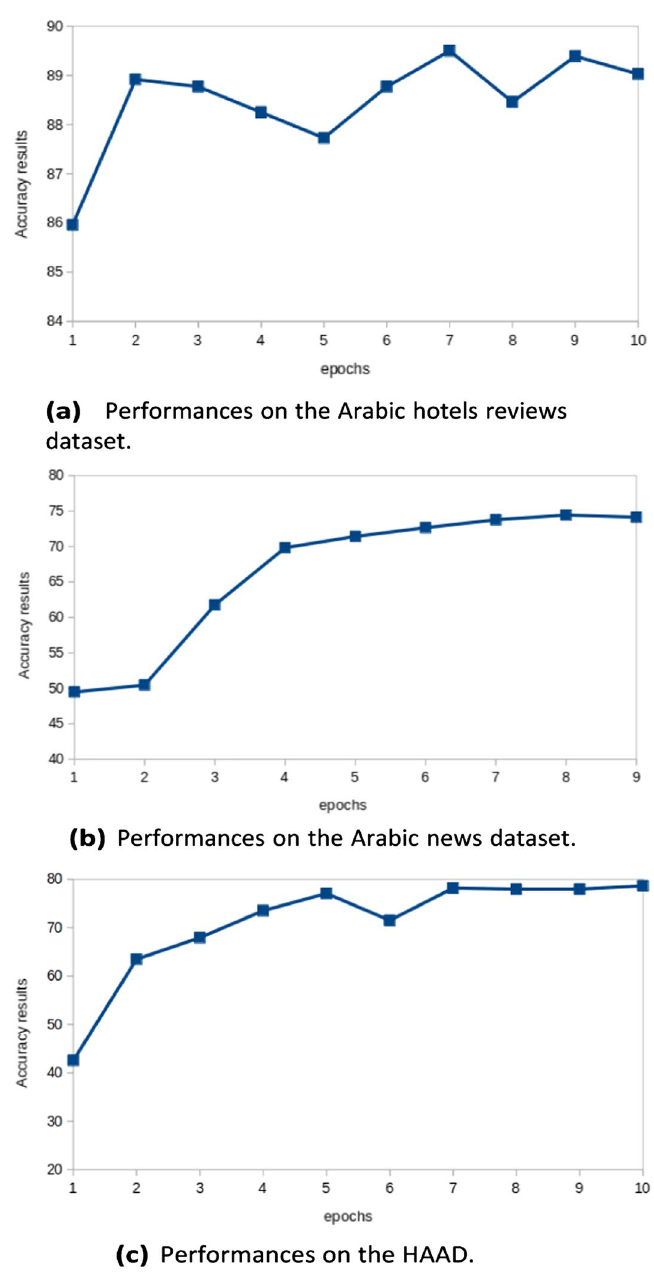
Fig. 5 The accuracy results on the development set for three different Arabic